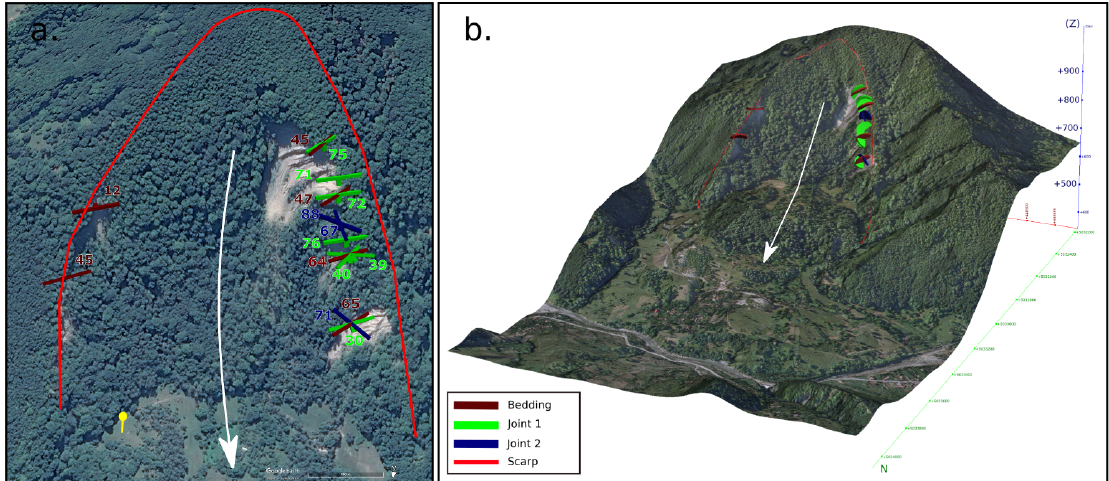
Figure 10. ( a ) Google Earth R (cid:13) views of the Balta rockslide with the strike-dip symbols of the measurement. The yellow icon has as coordinates of latitude 45 ◦ 26 (cid:48) 51.03 (cid:48)(cid:48) N and longitude 26 ◦ 21 (cid:48) 2.64 (cid:48)(cid:48) E. ( b ) 3D geomodel of the Balta rockslide with a 3D stereonet (view towards the south), the disks mark the local strike and dip